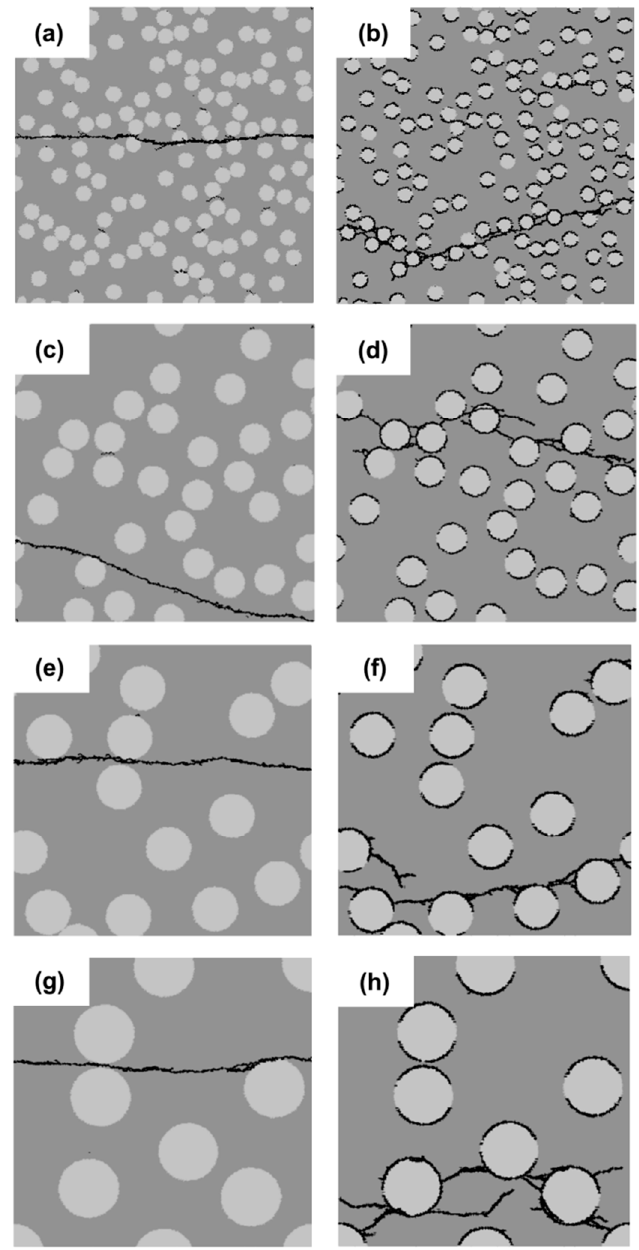
Figure 6. Micro-crack patterns of specimens with randomly-distributed filler particles for four different filler particle sizes (5 µm ( a , b ), 10 µm ( c , d ), 15 µm ( e , f ) and 20 µm ( g , h )).